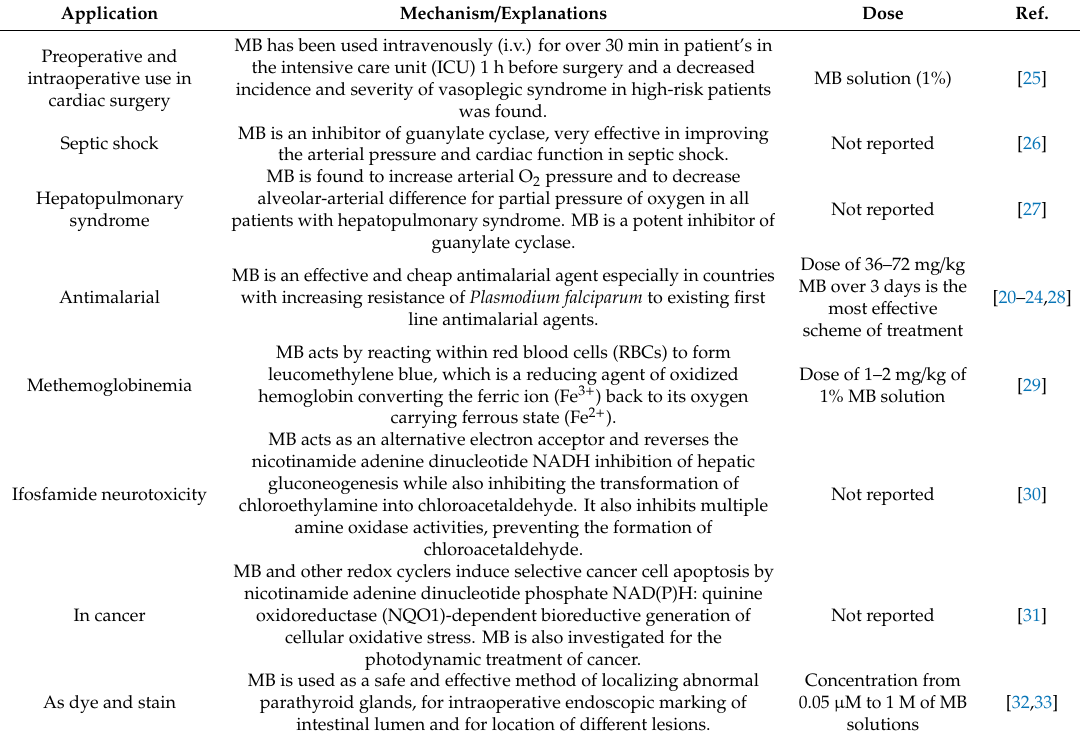
Table 1. Methylene blue in clinical